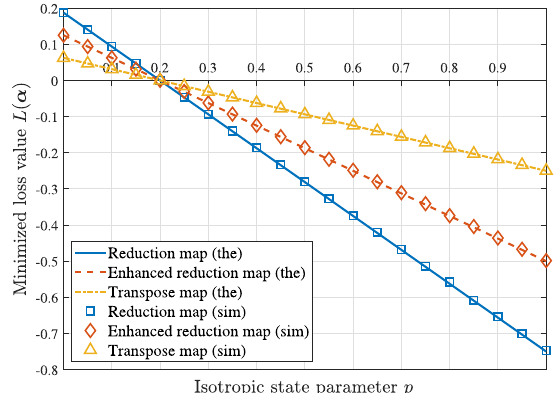
Fig. 6 Numerical results on the four-qubit isotropic states de fi ned in Eq. (43). Each line depicts the smallest eigenvalue of every isotropic state with parameter p ∈ [0, 1] under the corresponding map. This line of the smallest eigenvalues is a lower bound of the loss function L ( α ). Each marker depicts the minimized loss value obtained by simulations (sim) of Algorithm 1 on a chosen isotropic state, aligning with the theoretical (the)